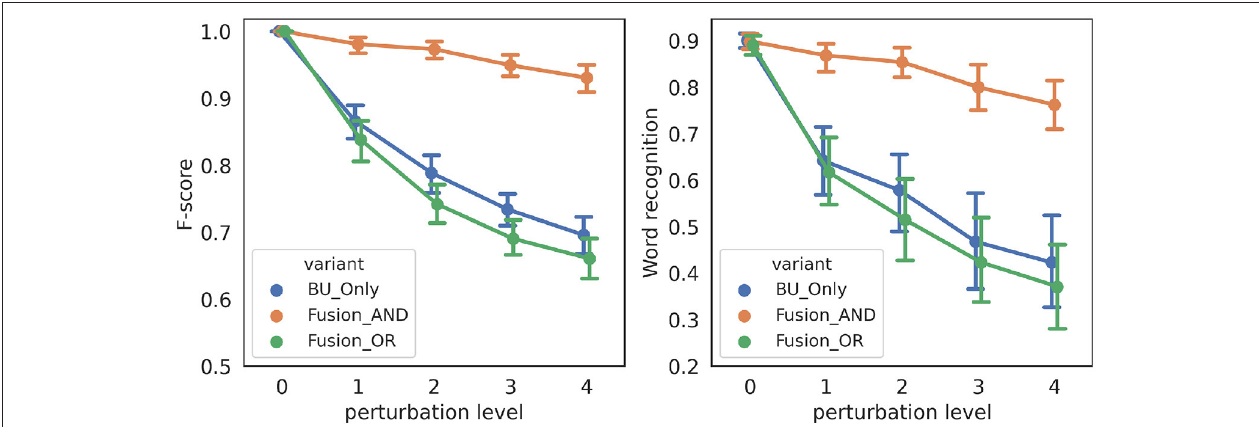
FIGURE 8 | Performance of the three variant models in the “noisy-event” condition. (Left) : F-score ( y -axis) as a function of the severity of degradation ( x -axis). (Right) : word recognition probability ( y -axis) as a function of the severity of degradation ( x -axis). Every data point is averaged, over 21 words, and, where applicable, over 10 independent simulations with different randomly drawn